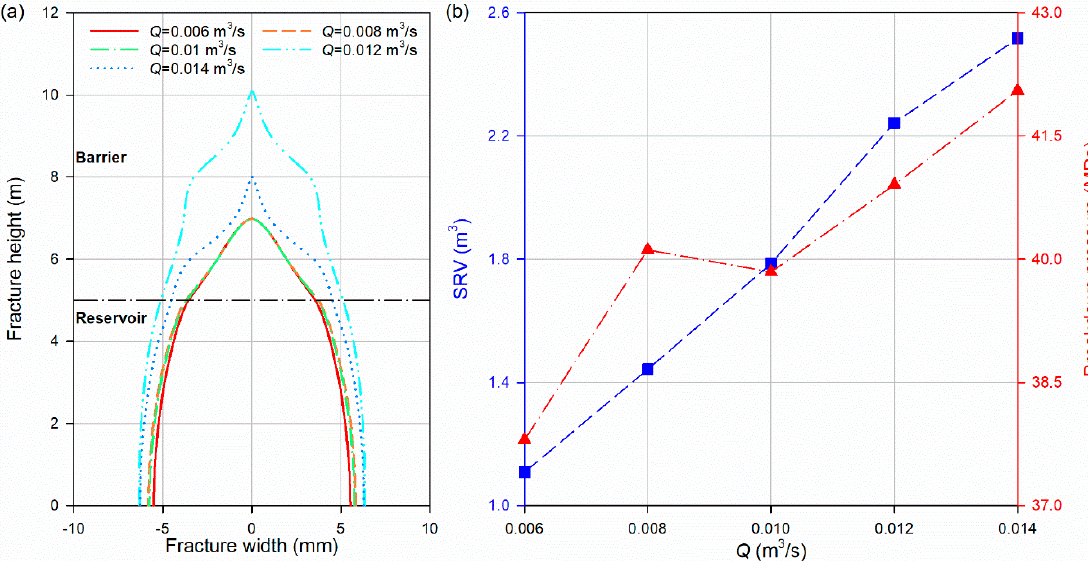
Figure 11. Fracture morphology, SRV, and breakdown pressure under different injection rates Q . ( a ) Profiles of fracture considering different Q ; ( b ) SRV and breakdown pressure under different Q .